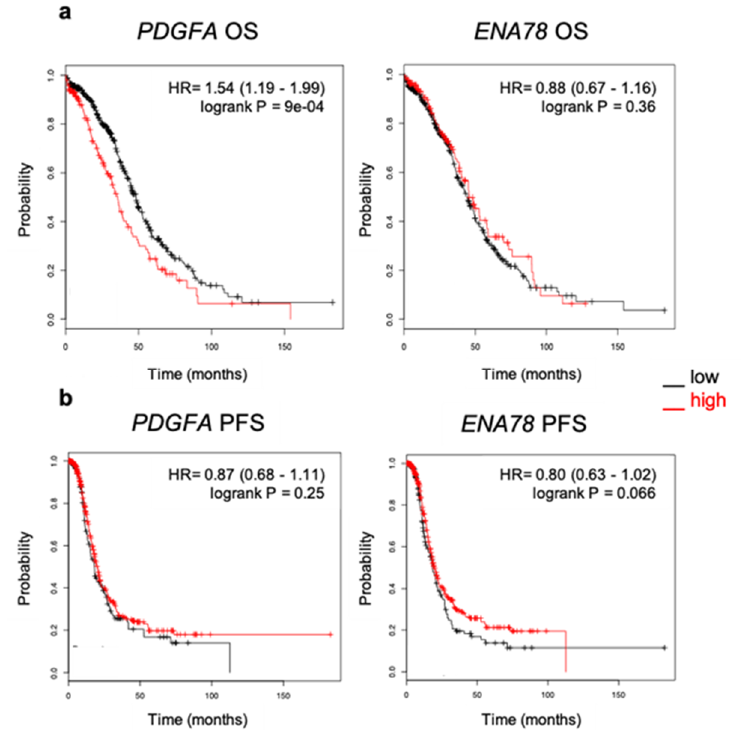
Figure 7. High expression of PDGFA correlates with poor outcome in ovarian cancer patients. ( a ) Kaplan – Meier curve of overall survival (OS) ( n = 557) and ( b ) progression-free survival (PFS) ( n = 522) in patients with serous epithelial ovarian carcinoma with high or low PDGFA and ENA78 ( CXCL5 ) mRNA obtained from KM Plotter using TCGA data. Affymetrix ID: 205463_s_at and 215101_s_at.